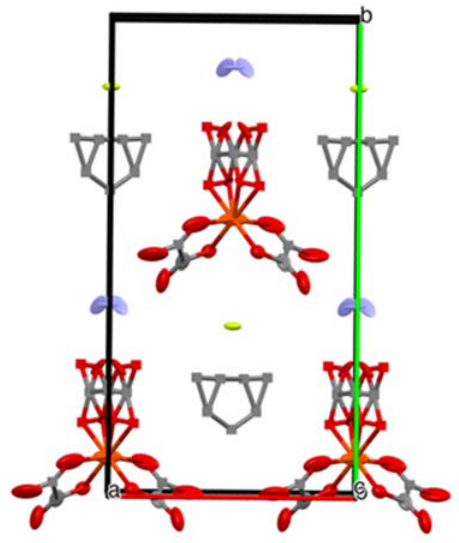
Figure 8. Anion layer of salt 3 .